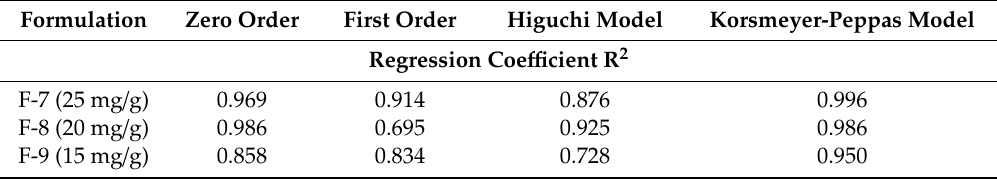
Table 2. Kinetics release models used to describe the release of ACTH from various